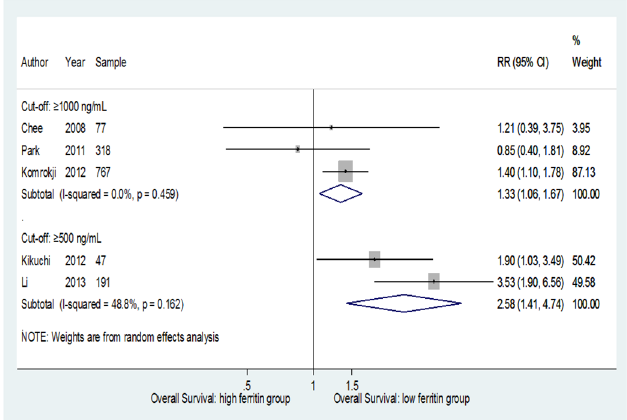
Fig 3. Forest plot of the subgroup analyses of the association of OS and SF according to SF (cid:21) 1000 ng/ mL and SF (cid:21) 500 ng/mL